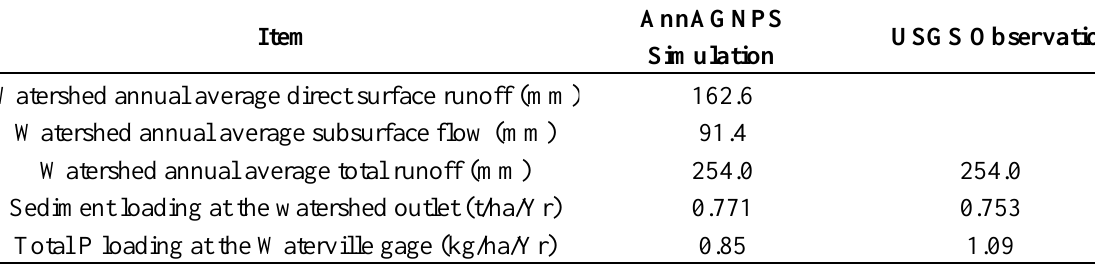
Table 7. Post-calibration model outputs of runoff, sediment and phosphorous as compared to observed values for existing watershed